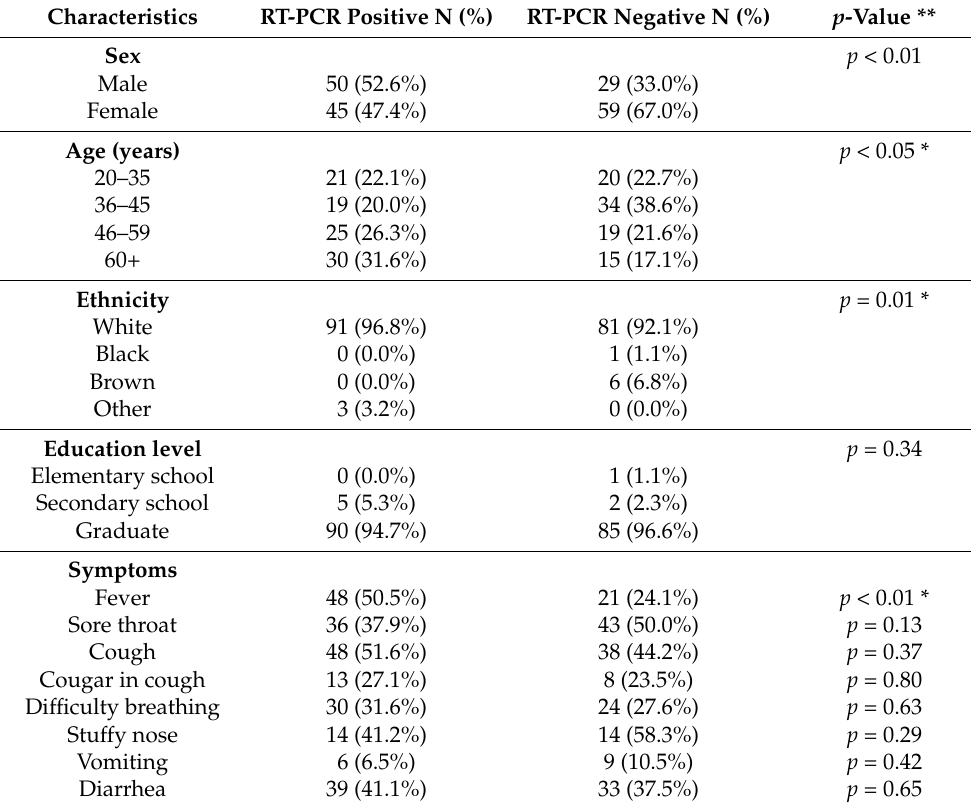
Table 1. Characteristics of included